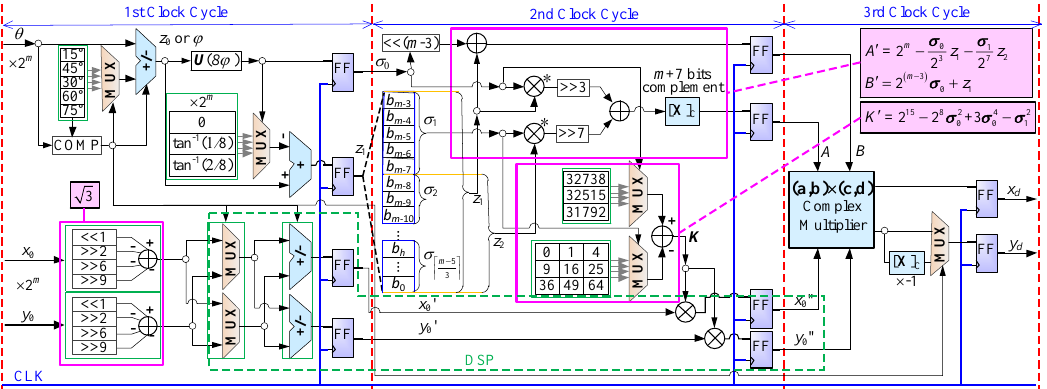
Figure 4. The architecture diagram of the NR-8 CORDIC algorithm on an FPGA. * The multipliers can be optimized as shifters and adders.